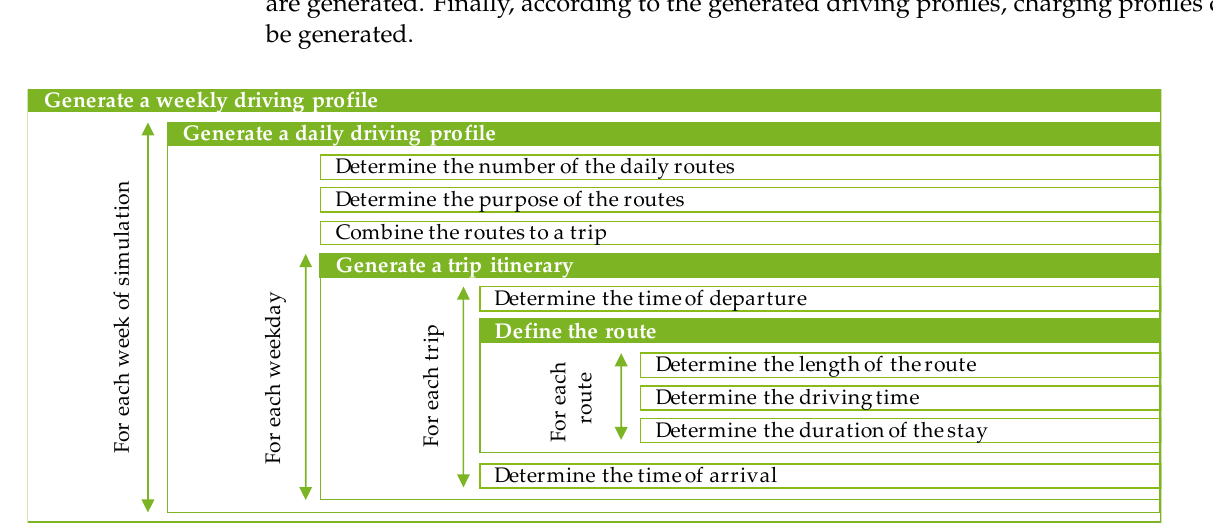
Figure 5. Simulation algorithm for generating probabilistic driving and load profiles [28].